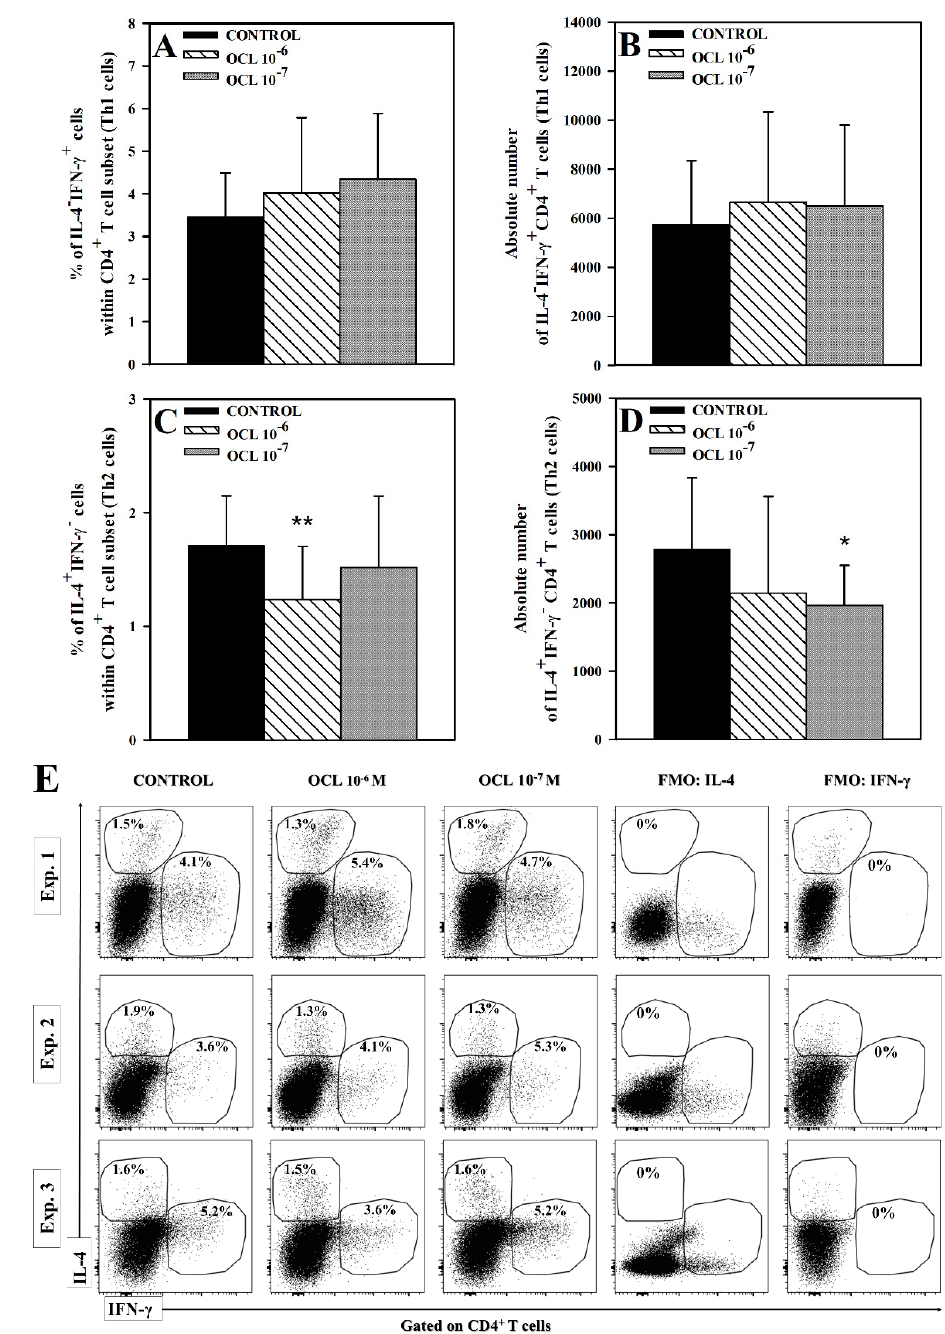
Figure 1. Effect of oclacitinib (OCL) on the number of IFN- γ - and IL-4-producing CD4 + T cells. The relative ( A , C ) and absolute count ( B , D ) of IFN- γ - and IL-4-producing CD4 + T cells were determined in cell cultures incubated with or without